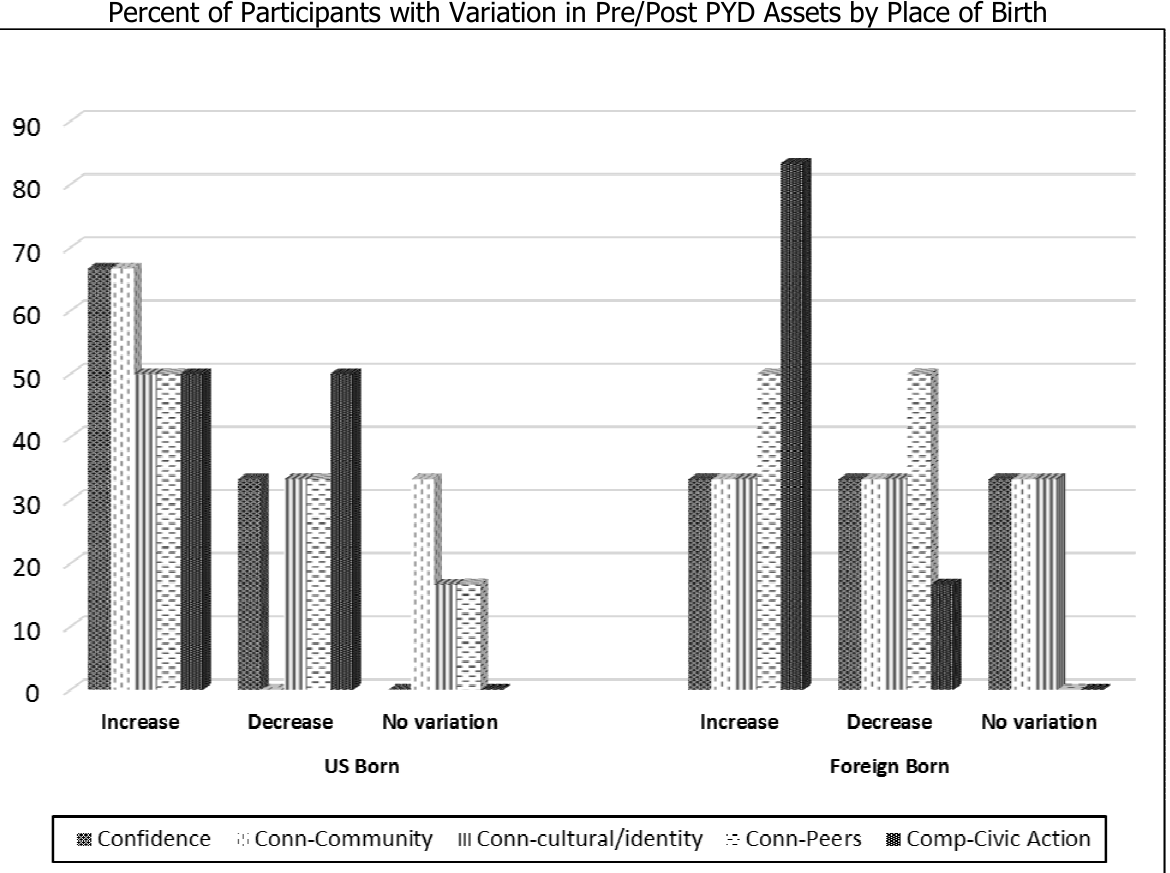
Percent of Participants with Variation in Pre/Post PYD Assets by Place of